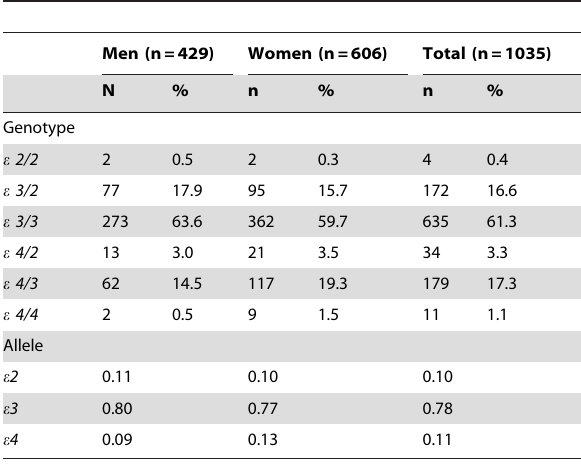
Table 1. Prevalence (%) of apolipoprotein E genotypes and frequency of alleles in the study population.